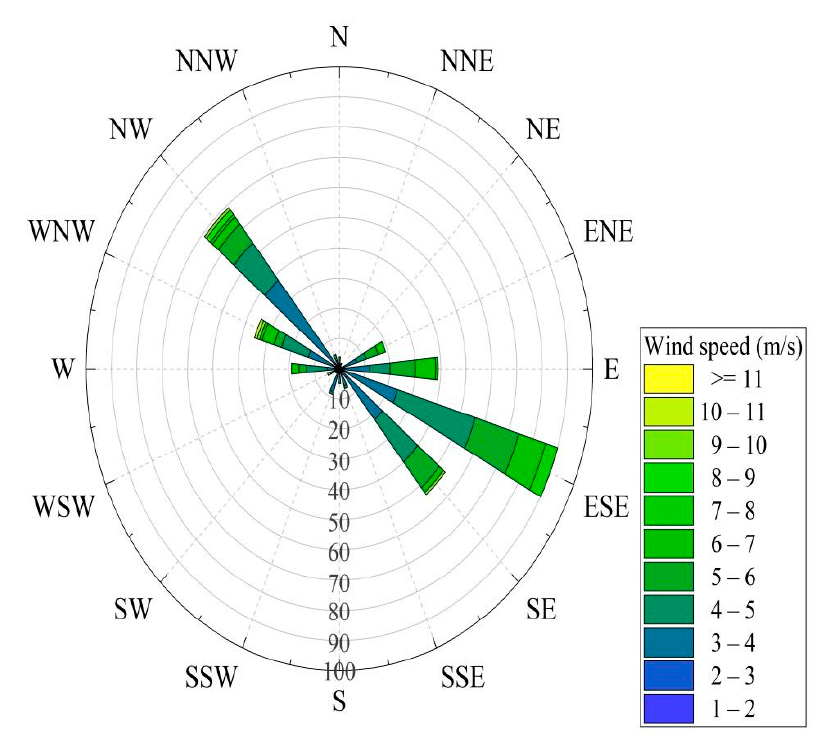
Figure 14. The wind direction map in Chaohu Lake 2019 (10, 20, 30, etc., indicate the number of days). The average wind speed on 24 October 2019 was 1.5 m/s, which was less than the critical value (3.8 m/s) for algae aggregation and movement [74]. Additionally, the maximum wind speed was 3.8 m/s. As can be seen in the HAB distribution in Chaohu Lake detected by Terra and Aqua on October 24 (Figure 15a,c), the HAB in the central part of Chaohu Lake is gradually moving in the east–southeast direction, in line with the maximum wind speed direction 14 (that is, the west-northwest direction). On 8 November 2019, the maximum wind speed was 2.9 m/s, and the maximum wind speed direction was 3 (that is, a northeasterly). HAB areas in Chaohu Lake were 31.75 and 43.6 km 2 , respectively, detected by Terra and Aqua. There was a low average wind speed (2 m/s) on Chaohu Lake on that day, which caused the algal particles to turn up and accumulate on the surface. The changes of HAB were also affected by wind waves, leading to the distribution location moving to the southwest (Figure 15b,d). Therefore, the multi-source remote sensing data can effectively monitor and reveal the diurnal change and development process of